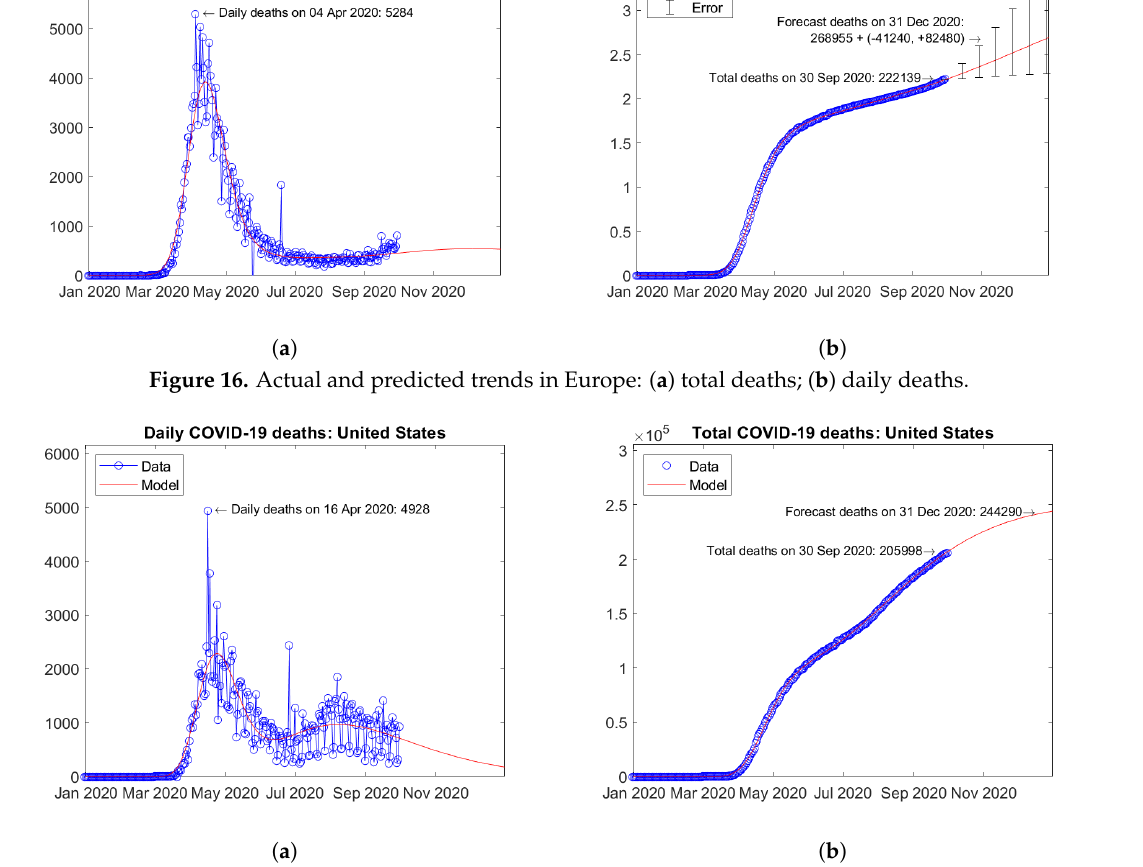
Figure 17. Actual and predicted trends in the United States: ( a ) daily deaths, ( b ) total deaths.